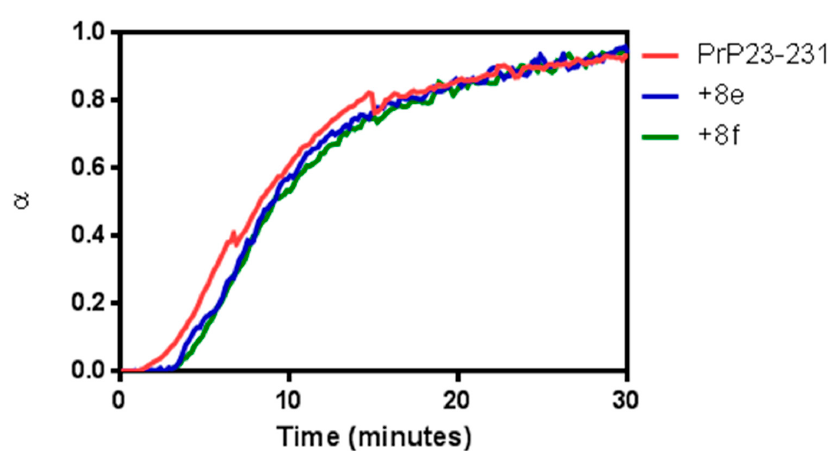
Figure 5. Representation of the fraction aggregated/non-aggregated ( α ) of PrP23-231 samples. PrP23-231 (1 μ M) was incubated at 60 °C in the absence (red line) or presence of compounds (1 μ M), and light scattering (LS) was monitored over time. LS increase was analyzed relative to initial LS values at 25 °C and normalized to the final values of each curve. Representative data of three independent experiments.